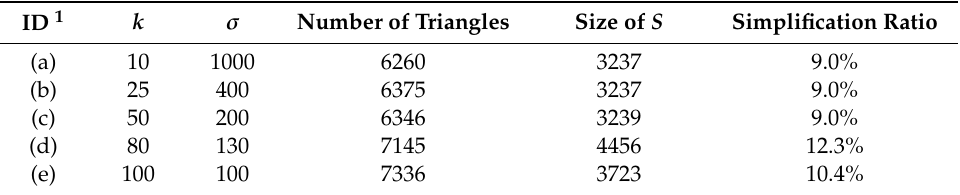
Table 3. The simplification surface parameters.